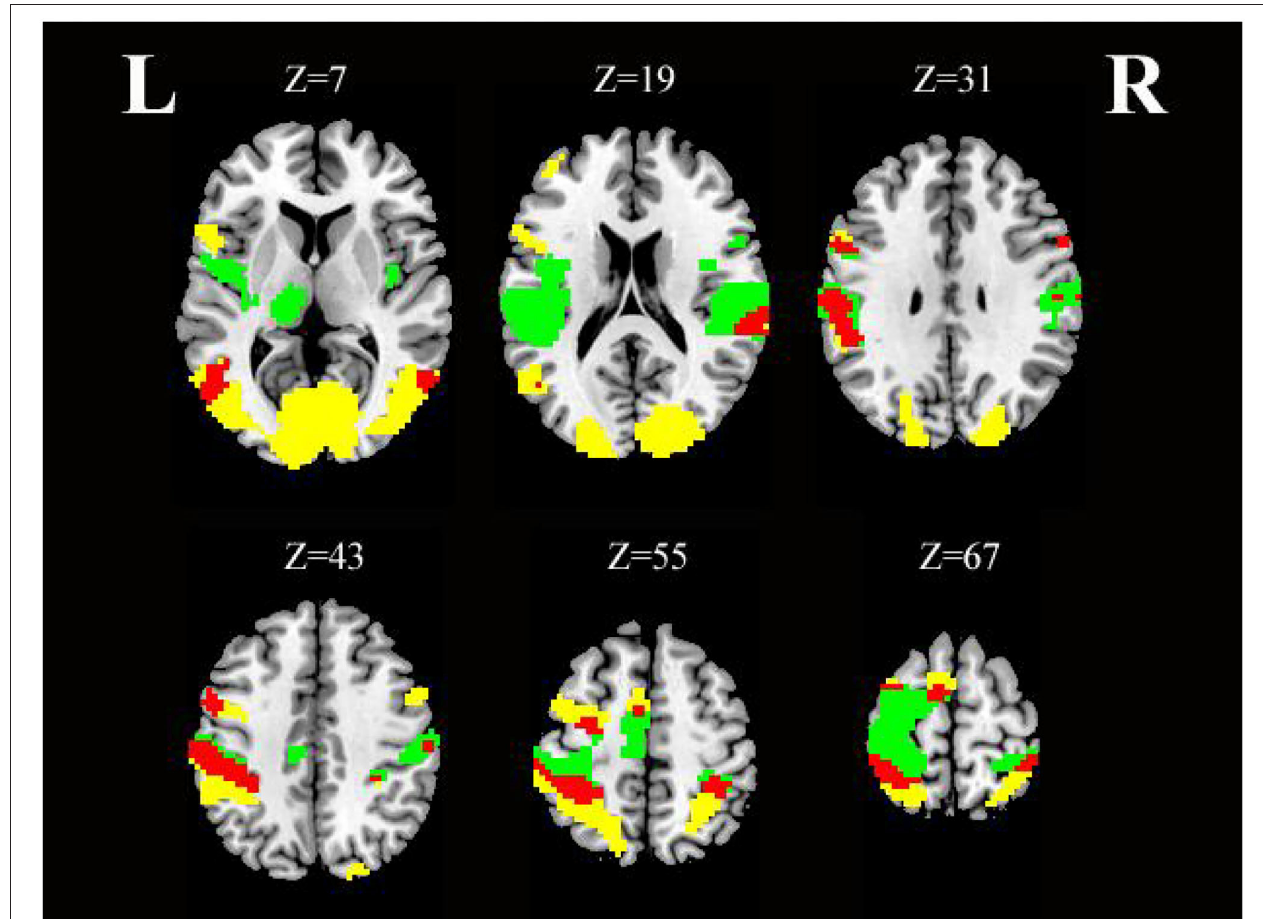
FIGURE 5 | Axial slices with corresponding Z -coordinates (MNI) from the t -value map for similar activation of SO and SS; yellow activation shows areas recruited by SO, green activation shows areas recruited by SS, and red areas represent activation overlap between SO and SS, respectively (voxel-level, FDR-corrected p < 0.001, cluster size > 10 voxels). MNI, Montreal Neurological Institute; SO, sensory observation; SS, somatosensory stimulation; FDR, false discovery rate; L, left; R, right